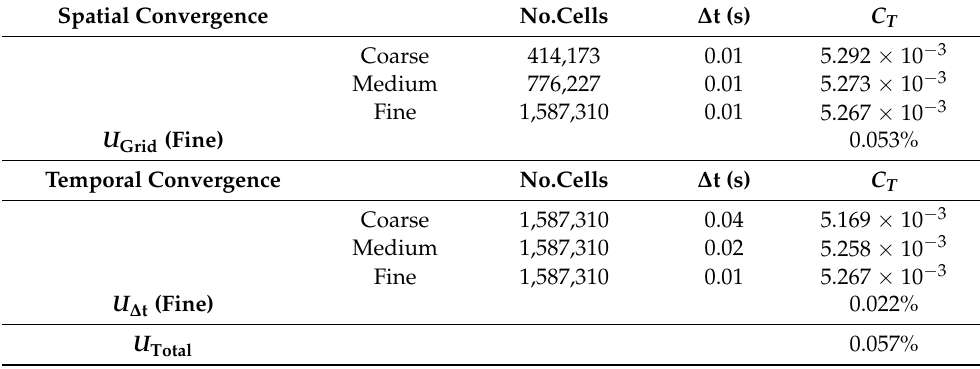
Table 2. Spatial and temporal convergence study of the Wigley hull simulation, Fr = 0.3, smooth hull. Spatial Convergence No.Cells ∆ t (s) C T Coarse 414,173 0.01 5.292 × 10 − 3 Medium 776,227 0.01 5.273 × 10 − 3 Fine 1,587,310 0.01 5.267 × 10 − 3 U Grid (Fine) 0.053% Temporal Convergence No.Cells ∆ t (s) C T Coarse 1,587,310 0.04 5.169 × 10 − 3 Medium 1,587,310 0.02 5.258 × 10 − 3 Fine 1,587,310 0.01 5.267 × 10 − 3 U ∆ t (Fine) 0.022% U Total